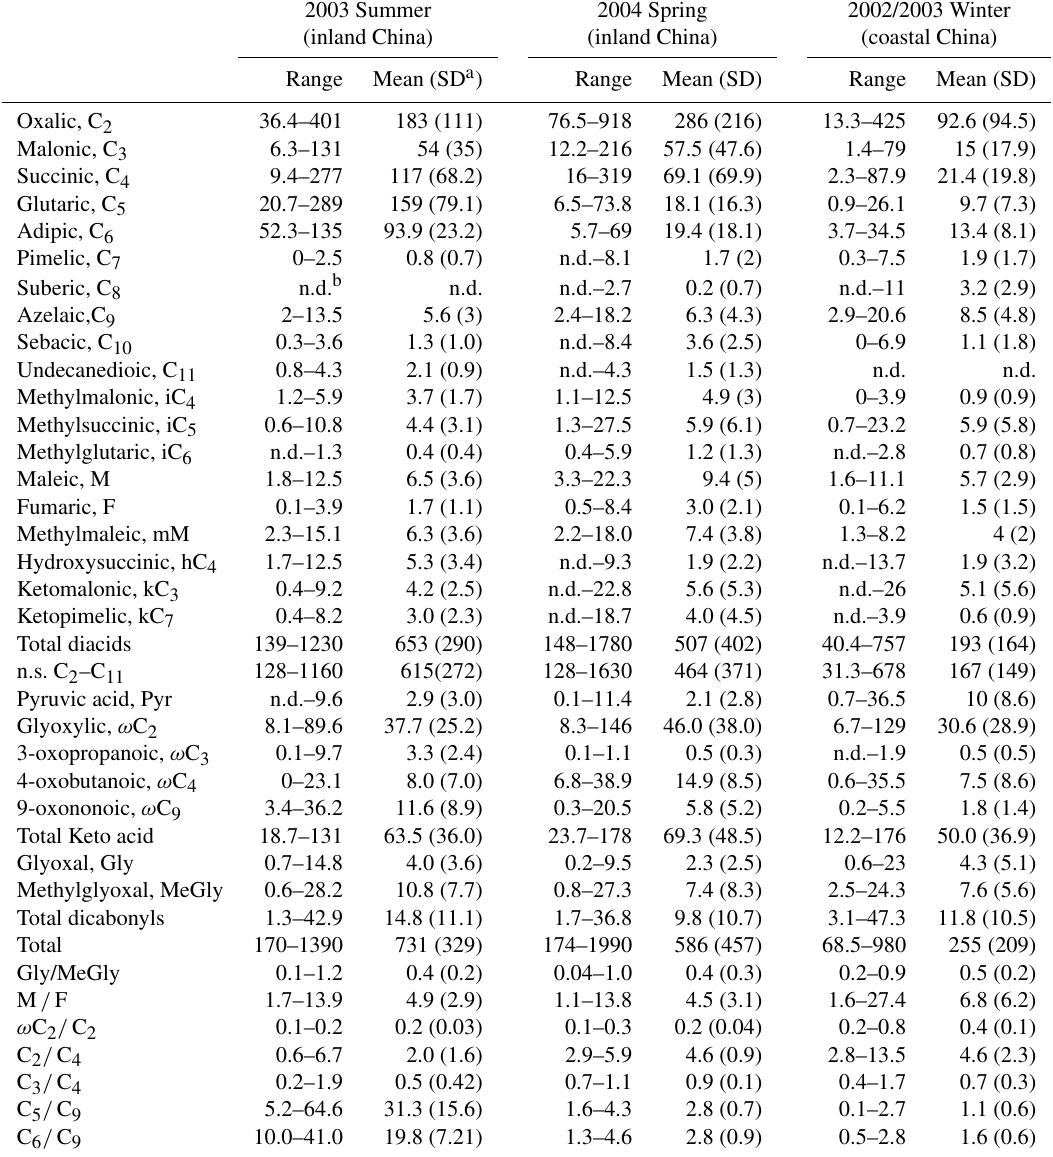
Table 1. Average concentrations (ngm − 3 ) and concentration ranges (ngm − 3 ) for straight chain diacids (C 2 –C 11 ), branched chain diacids (iC 4 –iC 6 ), unsaturated diacids (M, F and mM), multifunctional diacids (hC 4 , kC 3 and kC 7 ), oxoacids ( ω C 2 – ω C 4 , ω C 9 , and Pyr) and α - dicarbonyls (Gly and MeGly) of aerosol samples collected by aircraft campaigns over